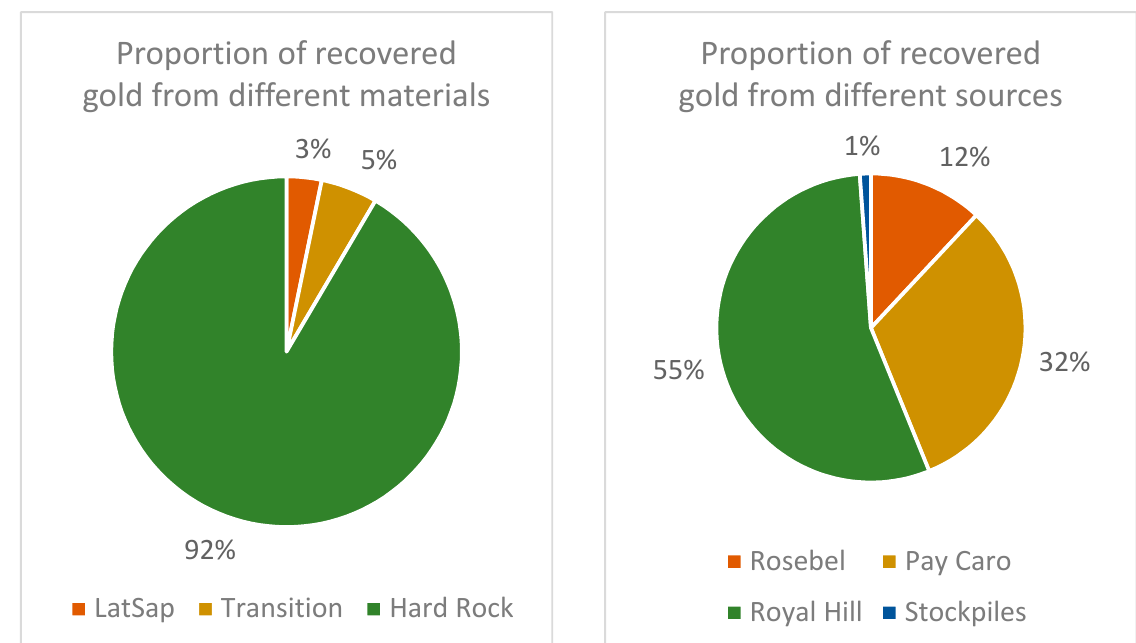
Figure 13. Proportion of recovered gold from different material types ( left ) and sources ( right ).